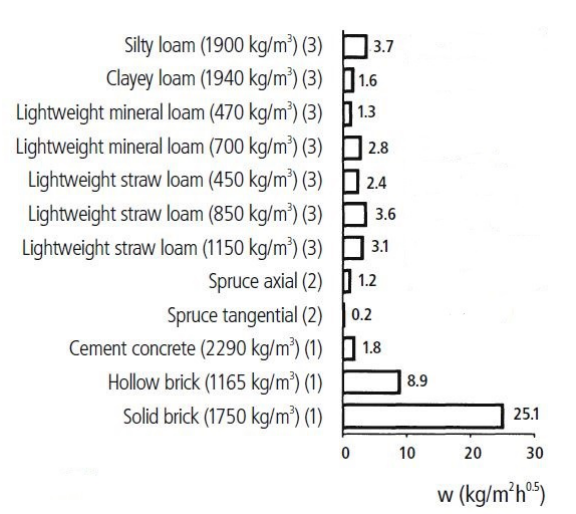
Figure 5. Water Absorption Coefficient for earth mixture in literature [3].